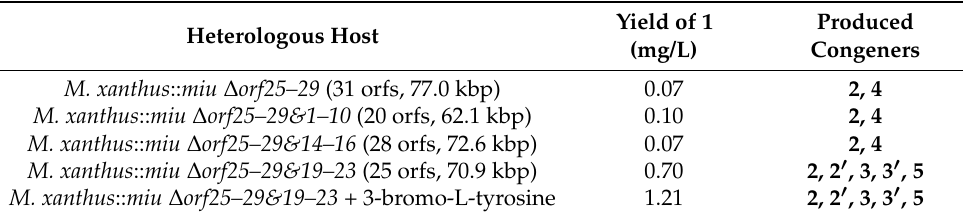
Figure 6. Production of miuraenamide A ( 1 ) and its congeners using multigene-disrupted heterol- ogous hosts. Extracted ion chromatogram (merged from m/z 684.2216, 606.3125, 656.2285, 670.2068, and 672.2217) of the extracts of M. xanthus :: miu ( A ), M. xanthus :: miu ∆ orf25–29 ( B ), M. xanthus :: miu ∆ orf25–29&1–10 ( C ), M. xanthus :: miu ∆ orf25–29&14–16 ( D ), and M. xanthus :: miu ∆ orf25–29&19–23 ( E , F ). Table 3. Production of miuraenamide A ( 1 ) and its congeners in multigene-disrupted heterolo- gous mutants.